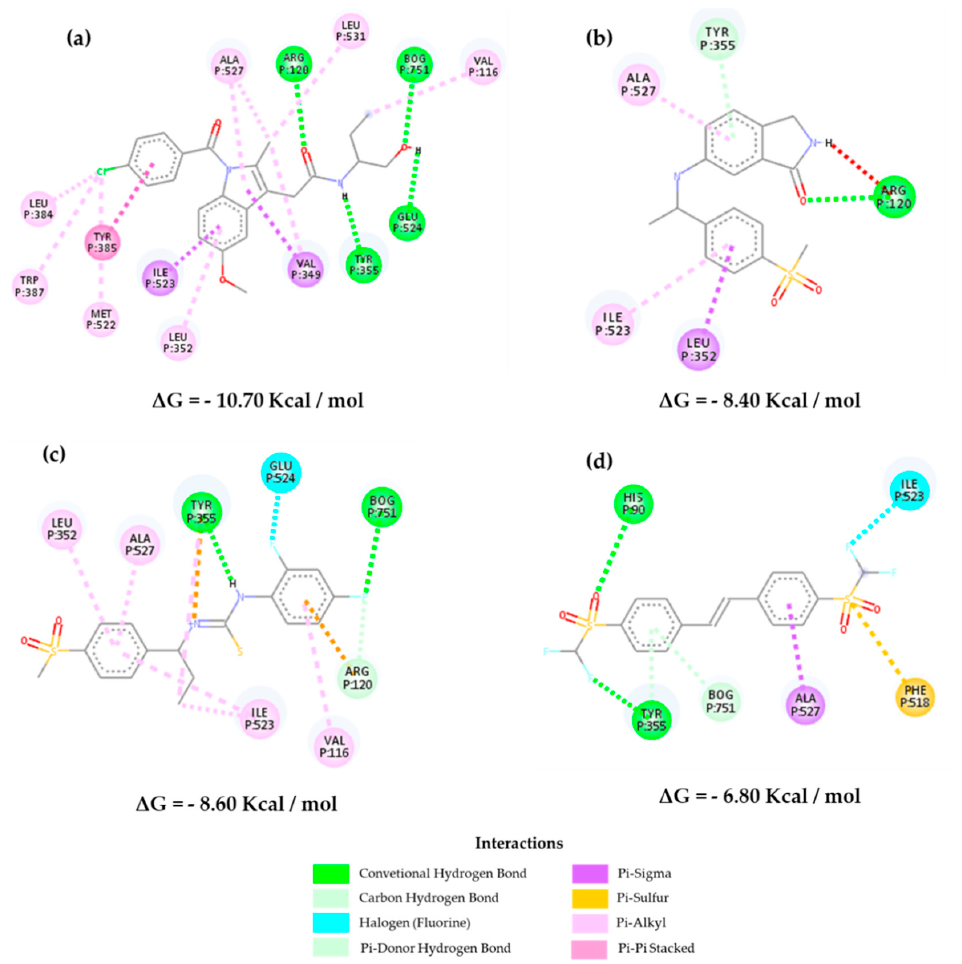
Figure 9. Interactions of the inhibitors ( a ) indomethacin, ( b ) Z-627 , ( c ) Z-964, and ( d) Z-814 with the active site of the structure of the indomethacin complex to the Ovis aries COX-1 (PDB 2OYE).